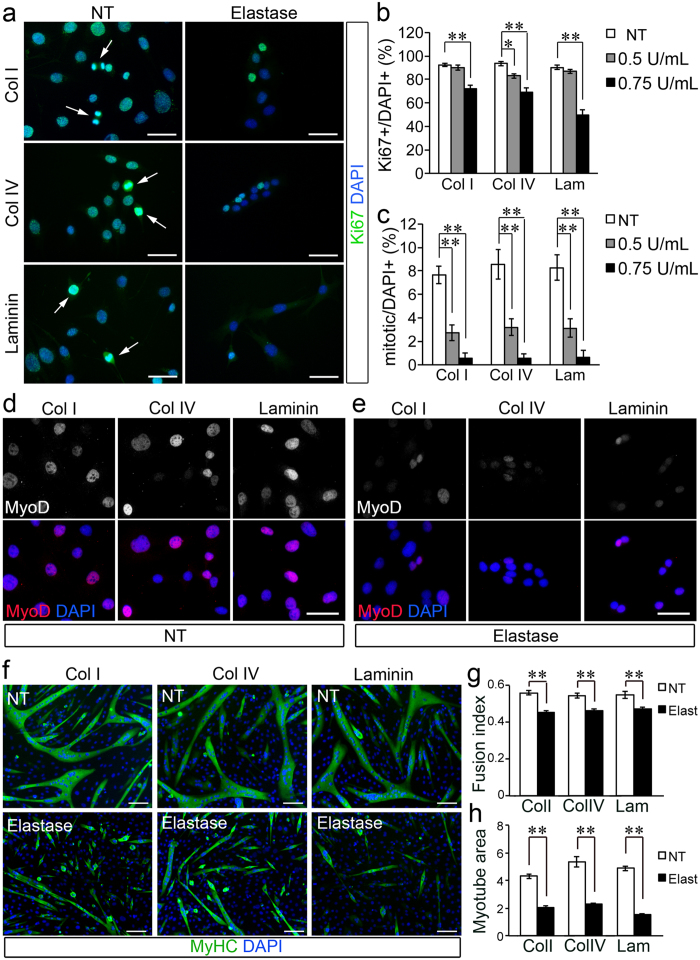
Elastase impairs myoblast proliferation, MyoD1 expression, myoblast fusion and myotube growth in a substrate-independent manner.(a) C2C12 myoblasts were cultured in growth medium in the presence/absence of 0.75 U/mL elastase for 24 hours then fixed and immunostained as indicated (NT = non-treated). Arrowheads show examples of mitotic cells identified by strong Ki67 staining and condensed chromatin. (b,c) Quantification of (a) where myoblasts were cultured in the presence/absence of either 0.5 or 0.75 U/mL elastase. Plots in (b,c) are averages of 10 technical replicates for each one of 3 biological replicates (n = 30 images per data-point). Error bars are S.E.M., *p < 0.05, **p < 0.01. Scale bars: 30 μm. (d,e) The levels of MyoD1 are decreased in myoblasts treated with elastase. C2C12 myoblasts were cultured in growth medium for 1 day then for an additional 1 day in the presence/absence of 0.6 U/mL elastase as indicated (NT = non-treated) prior to fixation and immunostaining to detect MyoD1 and nuclei (DAPI) as indicated. (f) Myoblast fusion and myotube growth are impaired by elastase treatment. C2C12 myoblasts were cultured in growth medium until confluent then switched to differentiation medium in the presence/absence of 0.15 U/mL elastase as indicated and maintained for an additional 4 days prior to fixation and immunostaining to detect myosin heavy chain (MyHC) and nuclei (DAPI). (g,h) Quantification of (f) where the fusion index is the percentage of MyHC + cells in myotubes over the total number of MyHC + cells (g), while the myotube area (h) is calculated as total MyHC + area per image. Plots are averages of 10–15 technical replicates across 4 biological replicates (n > 40 per data-point). NT = non-treated, Elast = 0.15 U/mL elastase. Error bars are S.E.M. **p < 0.01. Scale bars are: 30 μm in (a,b) and 100 μm in (f).